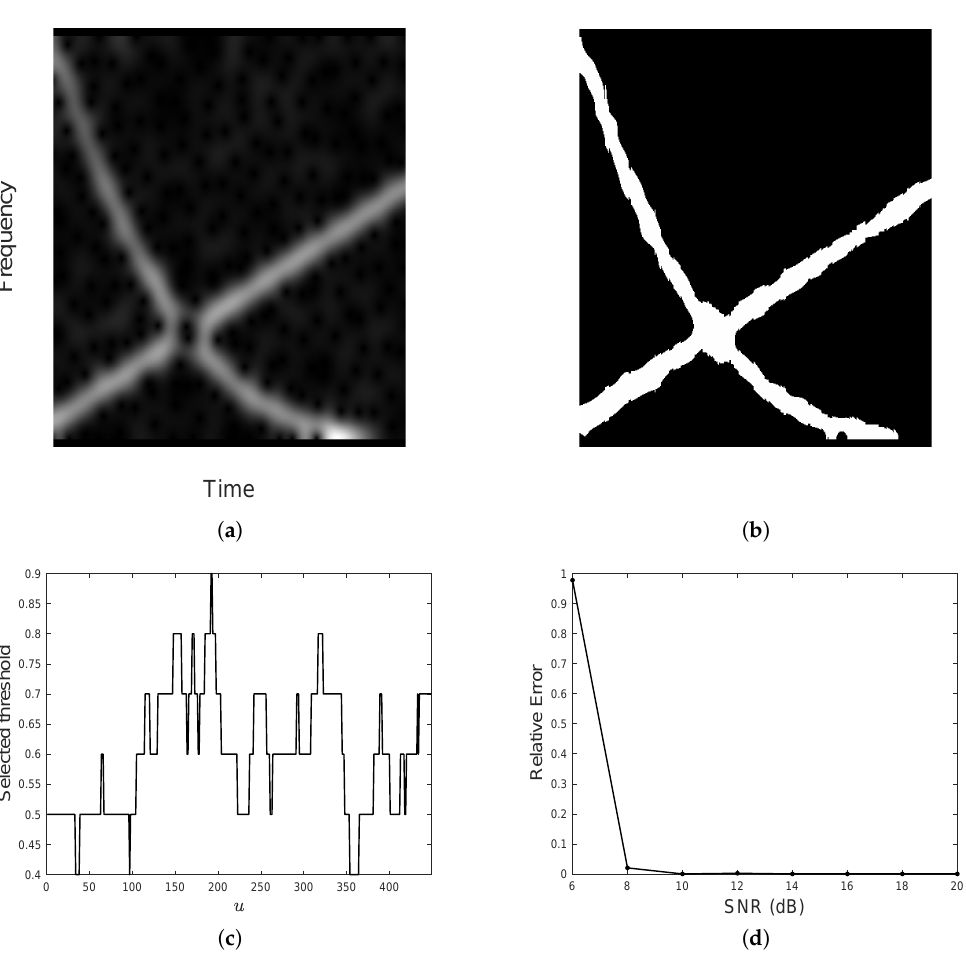
Figure 13. ( a ) Spectrogram of the two-component FM signal in Figure 11, embedded with AWG noise, SNR = 10 dB, s = 64. ( b ) Binary map derived from ( a ), with removed black holes. ( c ) Optimal threshold provided by MDL functional minimization, according to Equation (18). ( d ) Relative counting error against SNR.